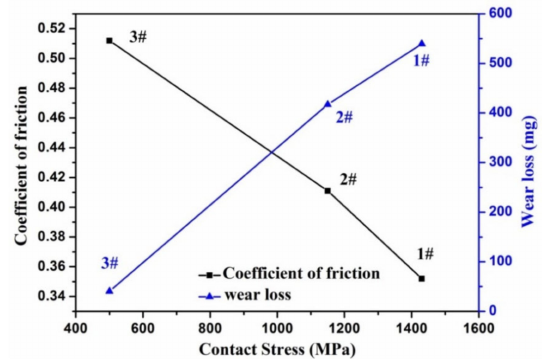
Figure 11. The relation among coe ffi cient of friction, wear loss and contact stress in the samples of 1#, 2# and